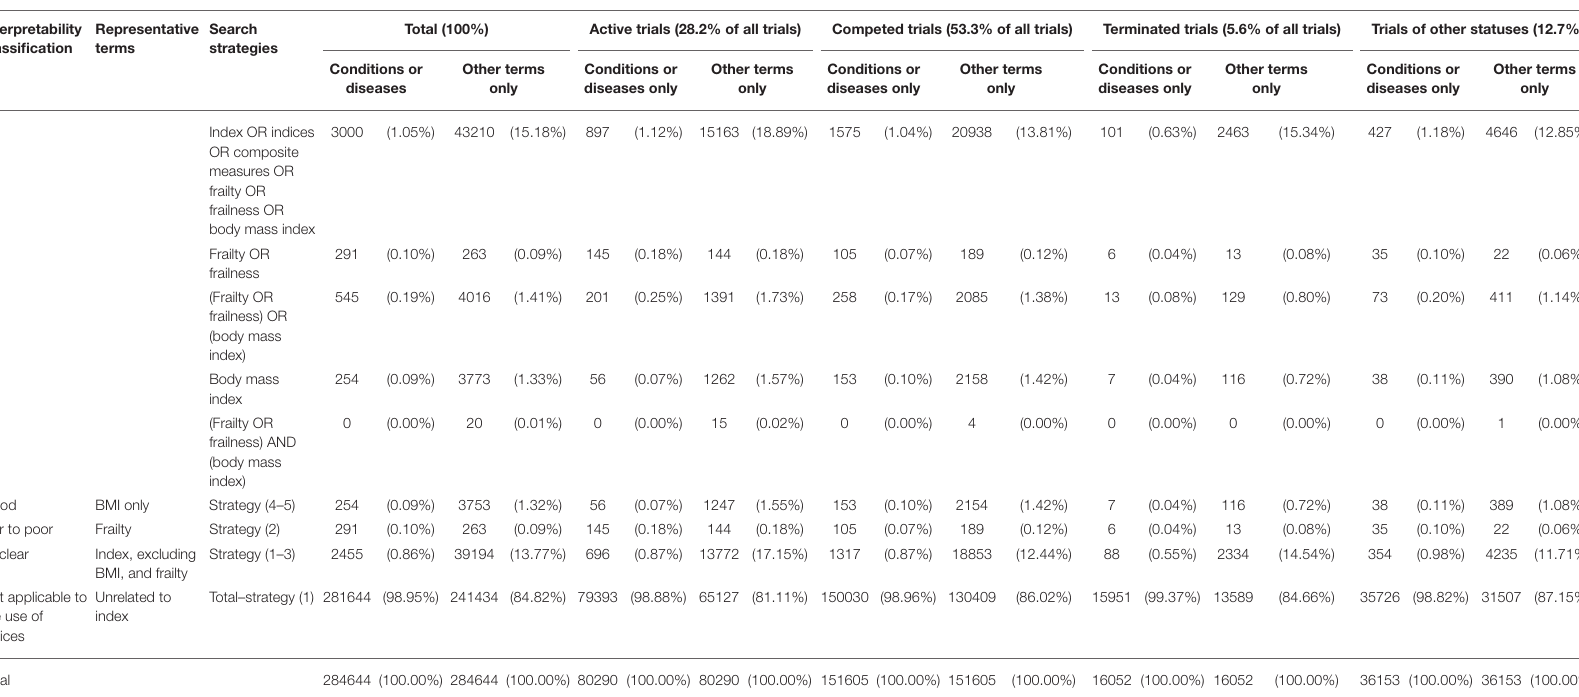
TABLE 1 | The distribution of indices of different interpretability across clinical trials of three